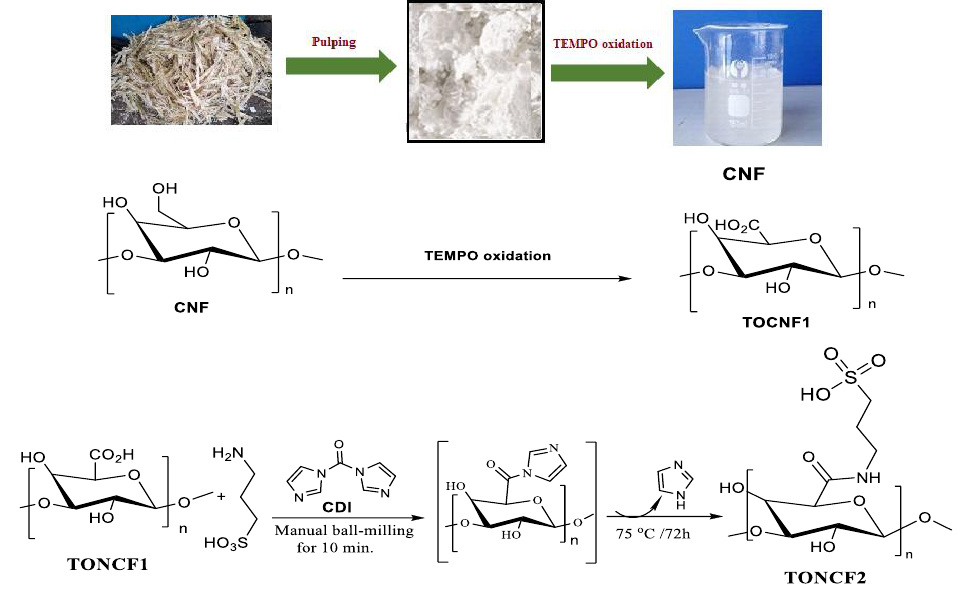
Figure 1. Extraction of cellulose pulp from sugar cane bagasse and its conversion into CNF. Oxidation of CNF by TEMPO affording TOCNF1. Then, the coupling between 3-APSA and TOCNF1 to generate TOCNF2.